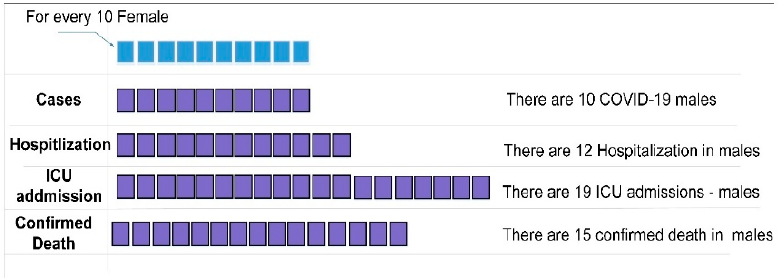
Figure 2. Statistics between males and females based on the number of infected cases.